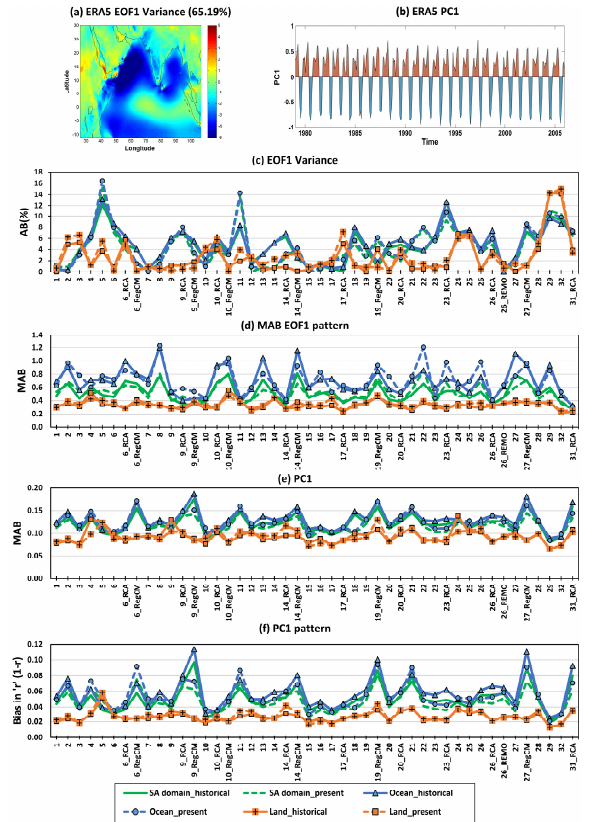
Figure 3. ( a ) The first empirical orthogonal function (EOF) of ERA5, and ( b ) first principal component (PC1) of ERA5 EOF1 historical monthly mean near-surface wind speed (WS) over South Asian (SA) domain. ( c − f ) Assessment Criteria Statistic (ASC) summary of CMIP5 GCMs and CORDEX RCMs in representing the spatio-temporal variability of monthly mean WS over South Asian (SA) domain for historical period (1979 − 2005) (green solid line), over SA domain for present period (2006 − 2019) (green dashed line), over ocean for historical period (blue solid line with triangle markers), over ocean for present period (blue dashed line with circle markers), over land for the historical period (orange solid line with plus sign markers) and over land for present period (orange dash line with square markers); ACS (AB = absolute bias; MAB = mean absolute bias, r = correlation coefficient) on y-axis and Model ID on x-axis.